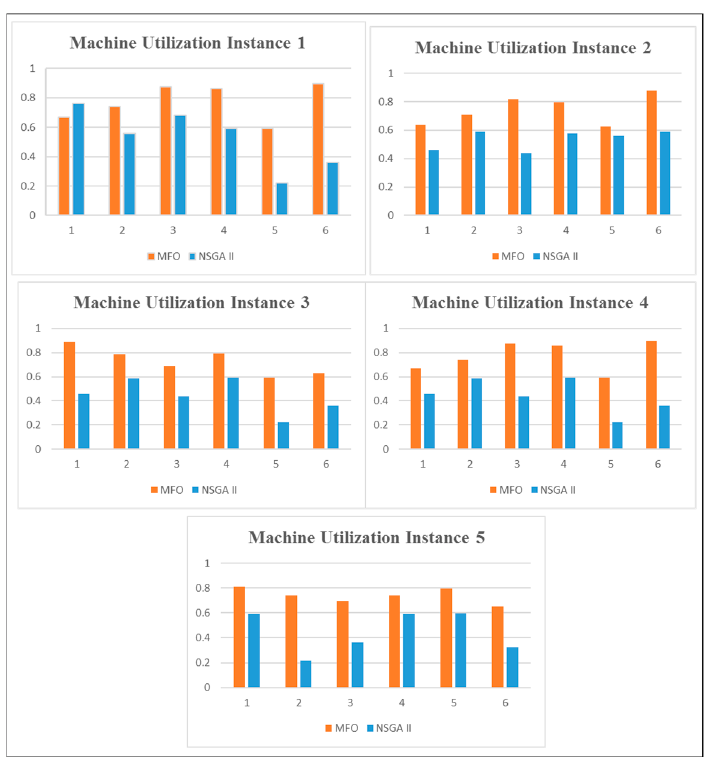
Figure 12. Utilization rate of different machines of instance 1–5.